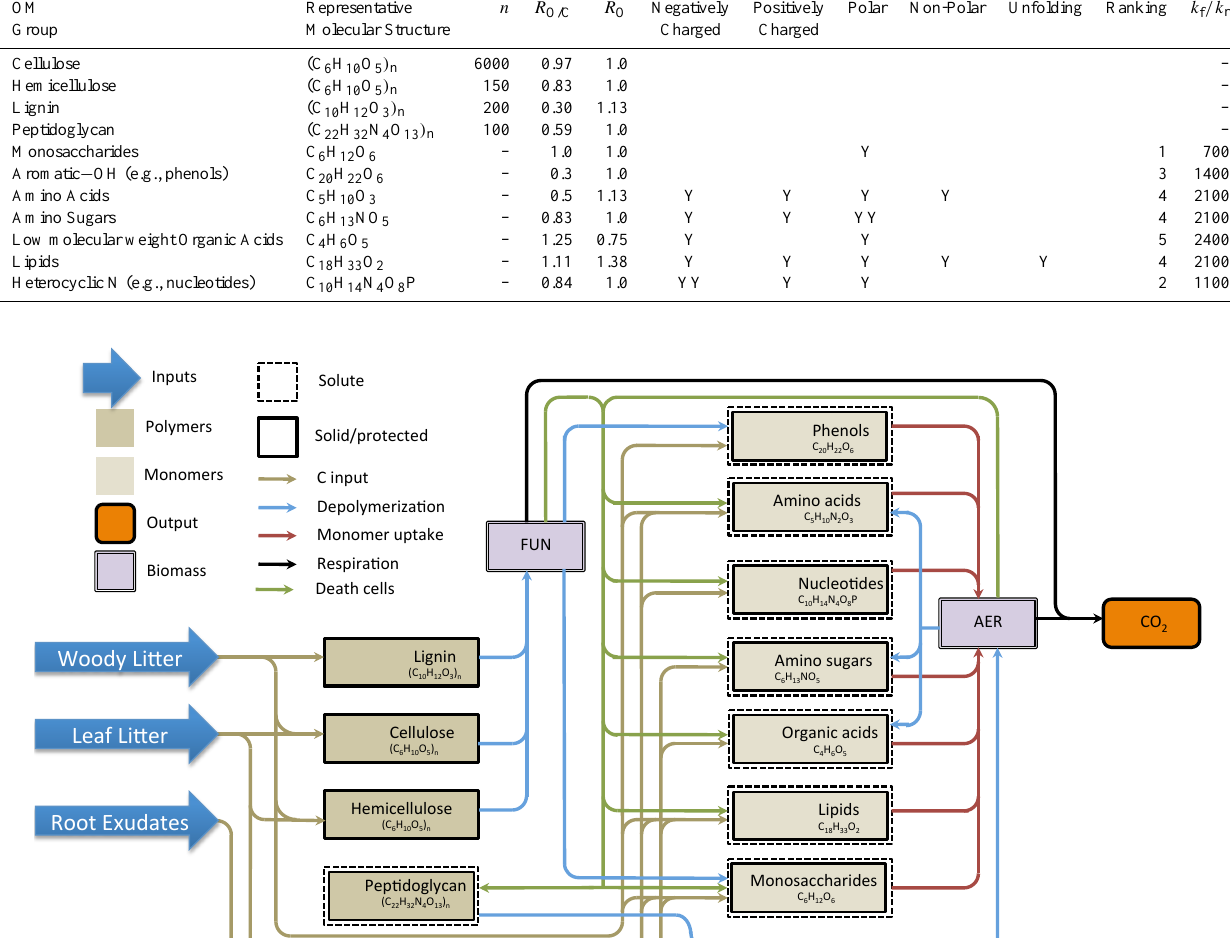
Table 1. Simplified overview of possible molecular functionalities (often dependent on solution pH, monomers only), number of repeating units for polymers, O / C ratios ( R (O/C) ), oxidative ratio ( R O ), and the sorption partitioning coefficient ( k f (cid:14) k r ) for relevant compound classes. Y indicates that compound class possesses this particular option to interact with other molecules or surfaces (YY = possesses the option in extraordinary fashion).